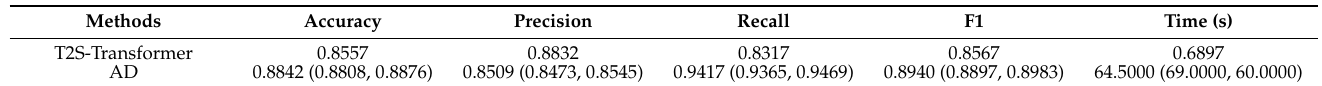
Table 3. Performance comparison between the proposed T2S-Transformer and the two attending doctors (average and individual performances are